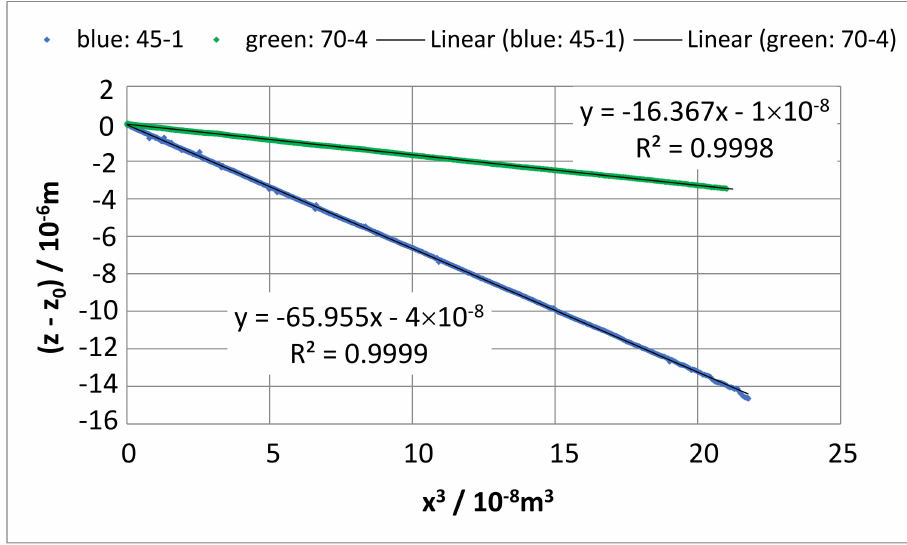
Figure 11. The negative bending elongation of the cantilever as function of the 3rd power of the load position x . The trendline (linear regression) gives the slope ∆ z / ∆ ( x 3 ) = F /(3 EI ), (Equation (7)). With Equation (1), the slope is related to F